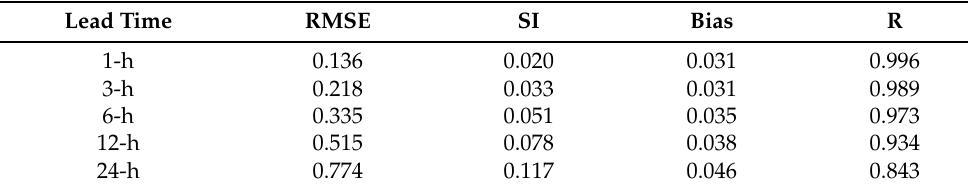
Table 5. Statistical indicators in the Conv-GRU model at different lead times.